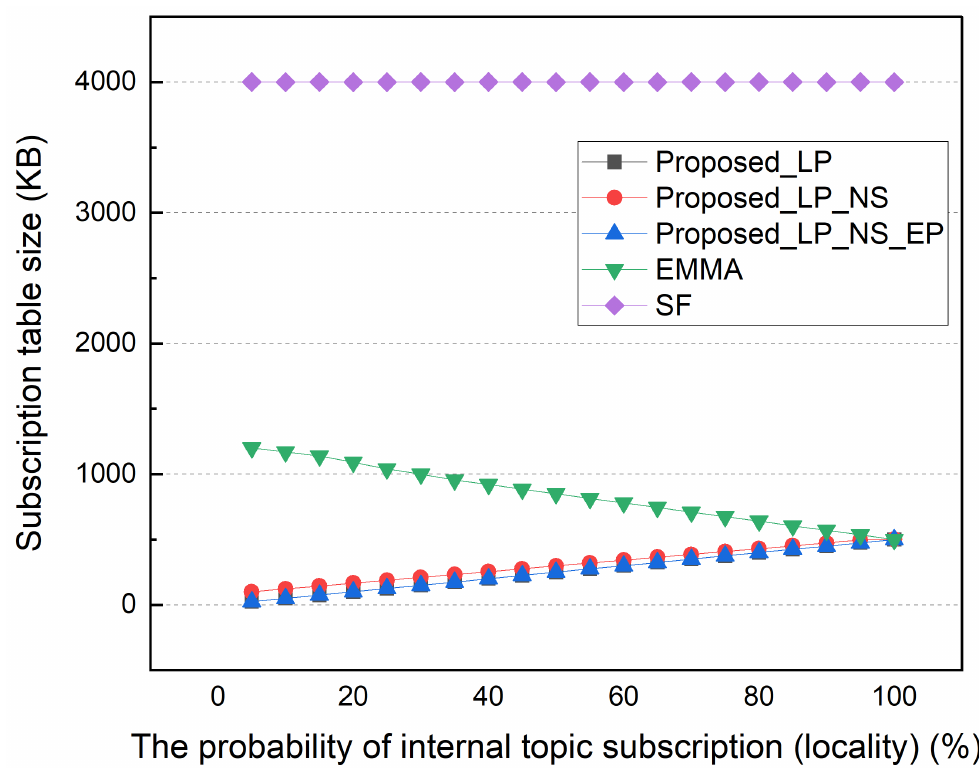
Figure 10. Subscription table size according to subscription